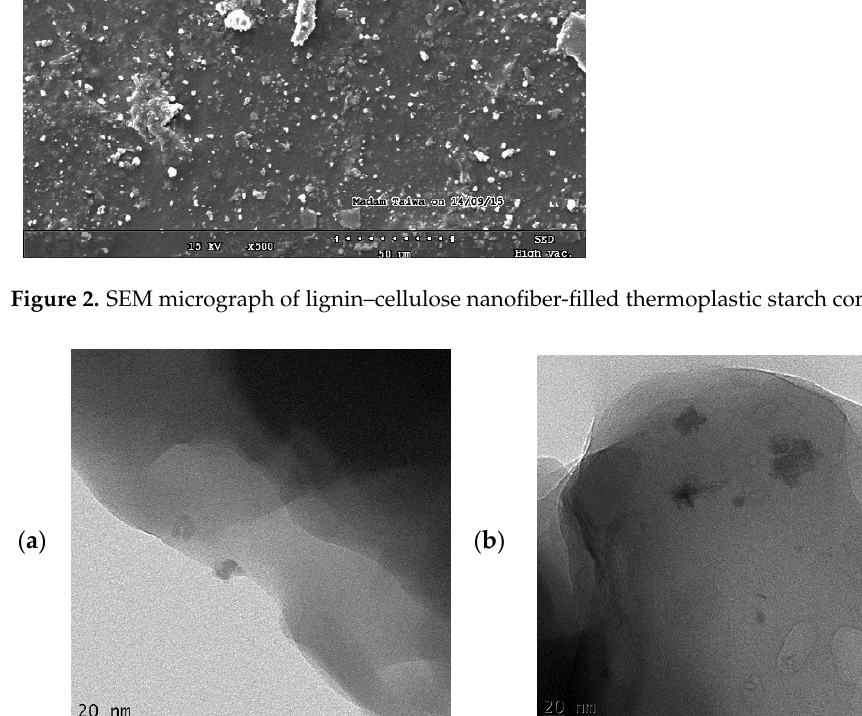
Figure 3. TEM micrographs of ( a ) cellulose nanofiber; ( b ) lignin fillers.